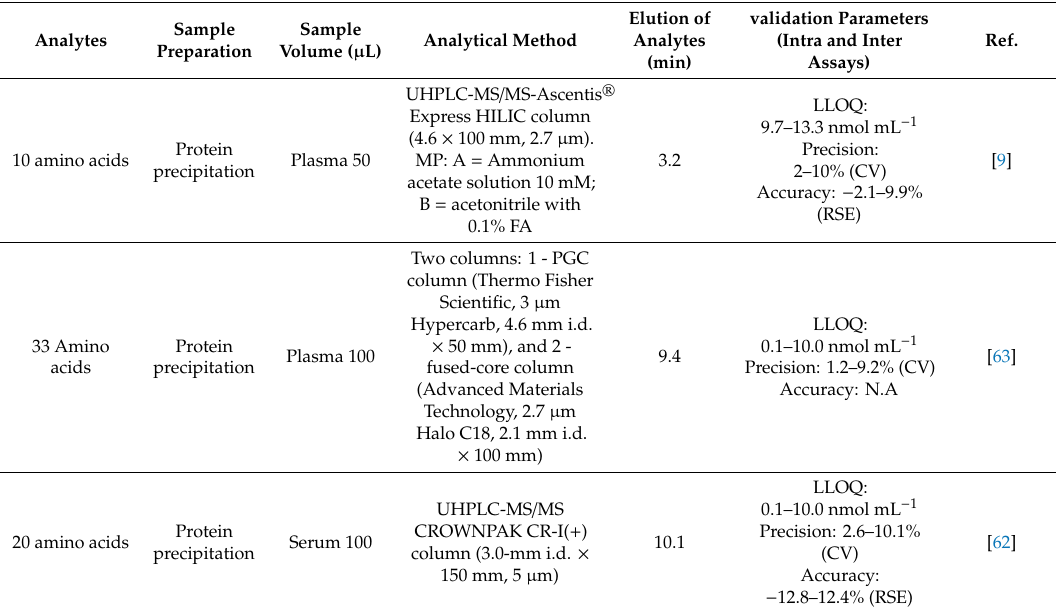
Table 6. Comparison of the developed method with other methods described in the